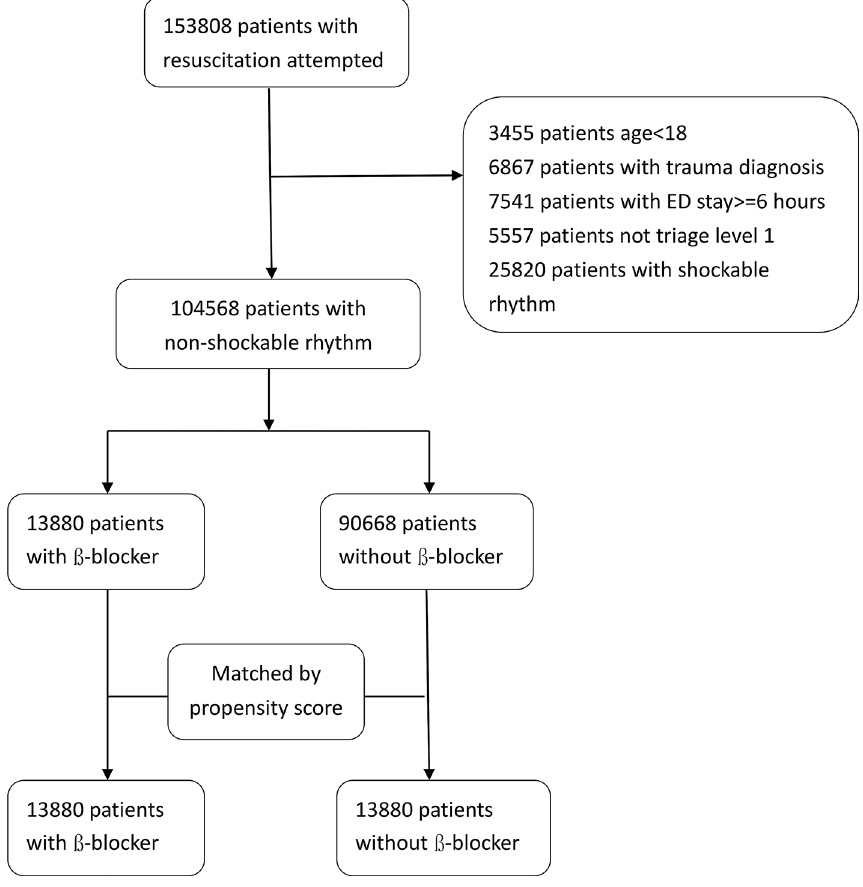
Figure 1. Flow chart of patient